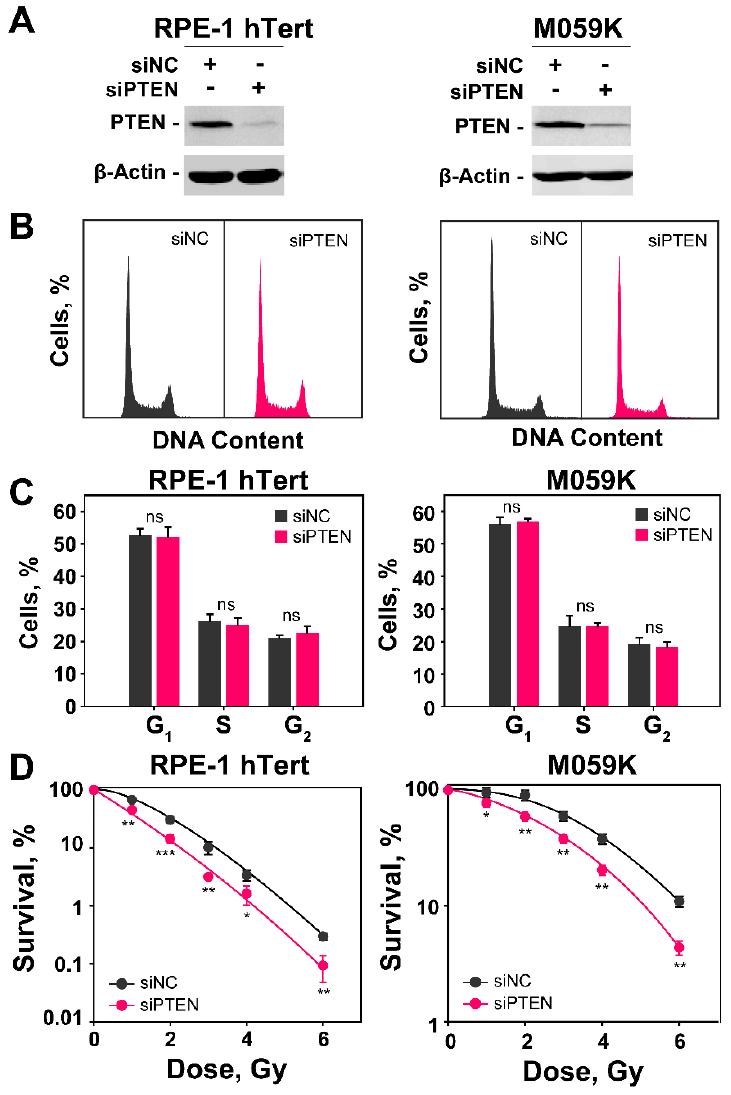
Figure 1. PTEN knockdown radiosensitizes RPE-1 hTert and M059K cells. ( A ) Western blot analysis of PTEN in RPE-1 hTert and M059K cells transfected with specific siRNA targeting PTEN protein; β -actin serves as loading control. ( B ) Flow cytometry histograms of RPE-1 hTert and M059K cells after transfection with PTEN siRNA. ( C ) Distribution of PTEN knock-down RPE-1 hTert and M059K cells in the different cell cycle phases. The analysis shows no significant differences between negative control (siNC) and PTEN knock-down (siPTEN) cells. ( D ) Clonogenic survival experiments of RPE-1 hTert and M059K cells transfected or not with PTEN siRNA. Data represent the mean ± SD from three independent experiments. The significance level, or p -value, is calculated using the two-tailed, Student’s t -test: ns (not significant), * p < 0.05, ** p < 0.01, *** p <